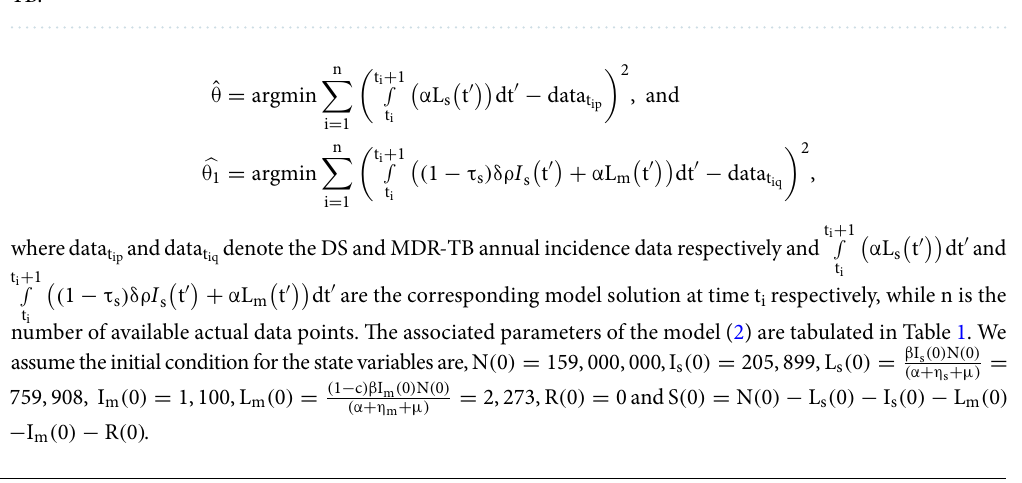
Figure 1. Reported Bangladesh TB annual incidence data as estimated by the WHO (red dots) and the corresponding best fit (blue solid curve): (left) drug-susceptible (DS) TB and (right) multidrug-resistant (MDR)